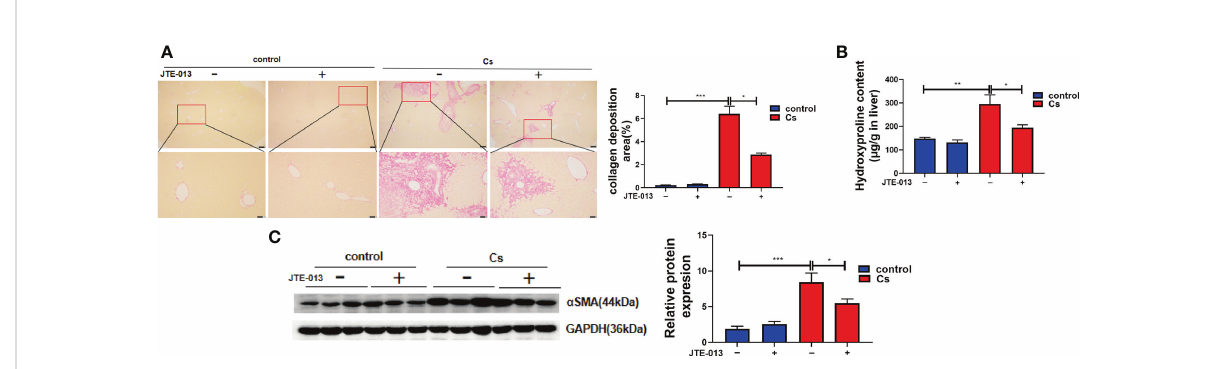
FIGURE 5 Inhibition of S1PR2 abated periductal fi brosis in BALB/C mice after C. sinensis infection. (A) The Sirius Red ’ s staining of the hepatobiliary tissue was carried out in the control and C. sinensis -infected mice under 100× and 200× microscope. (B) The measurement of hydroxyproline content in hepatobiliary tissue of control and C. sinensis -infected mice. (C) The protein expression of alpha-SMA in hepatobiliary tissue of control and C. sinensis -infected mice. Compared with indicated groups, * P <0.05, ** P <0.01, *** P